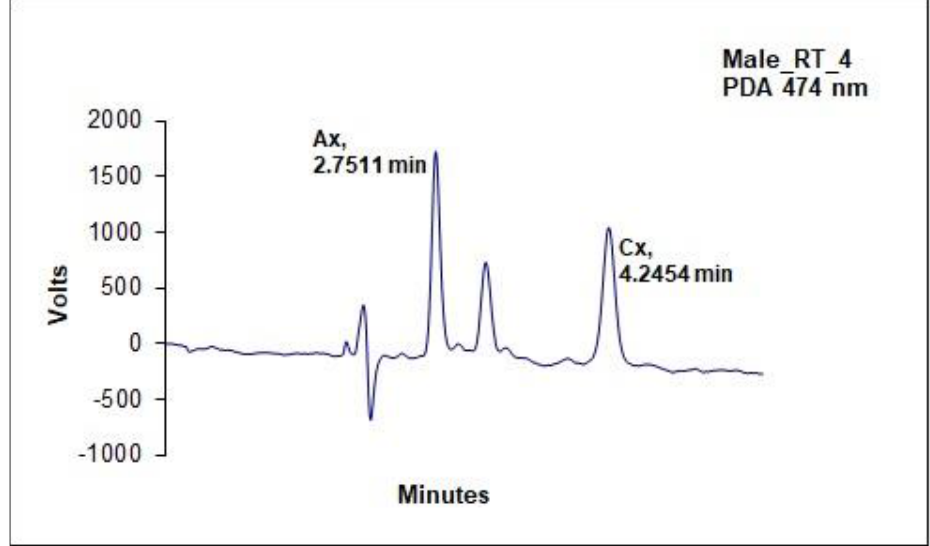
Figure 3. Typical chromatogram of sample solution of male gonads.